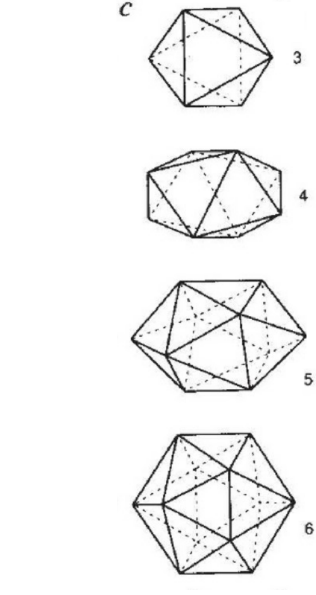
Figure 7. Murzin–Finkelstein polyhedra. ( a ) and ( b ) show how the helices in two all-alpha proteins can be mapped to edges of the solids. ( c ) The set of polyhedra supporting three up to six helices. Including the tetrahedron, which supports two helices (not shown), three of the polyhedra are Platonic solids.